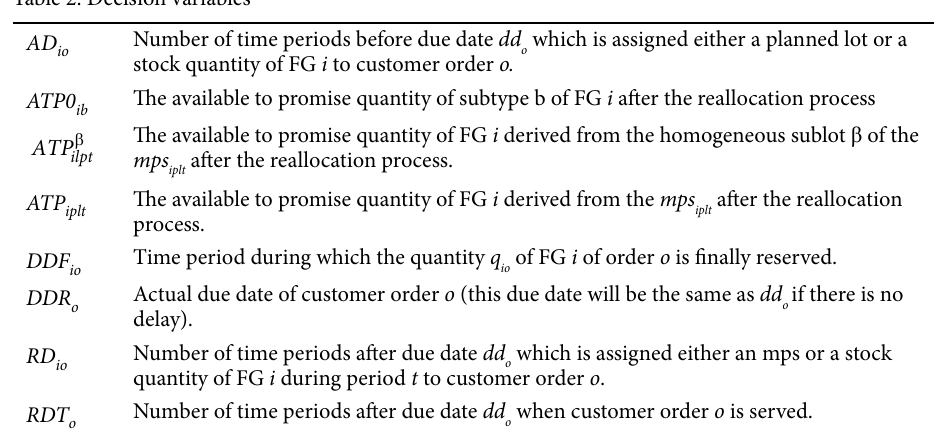
Table 2. Decision